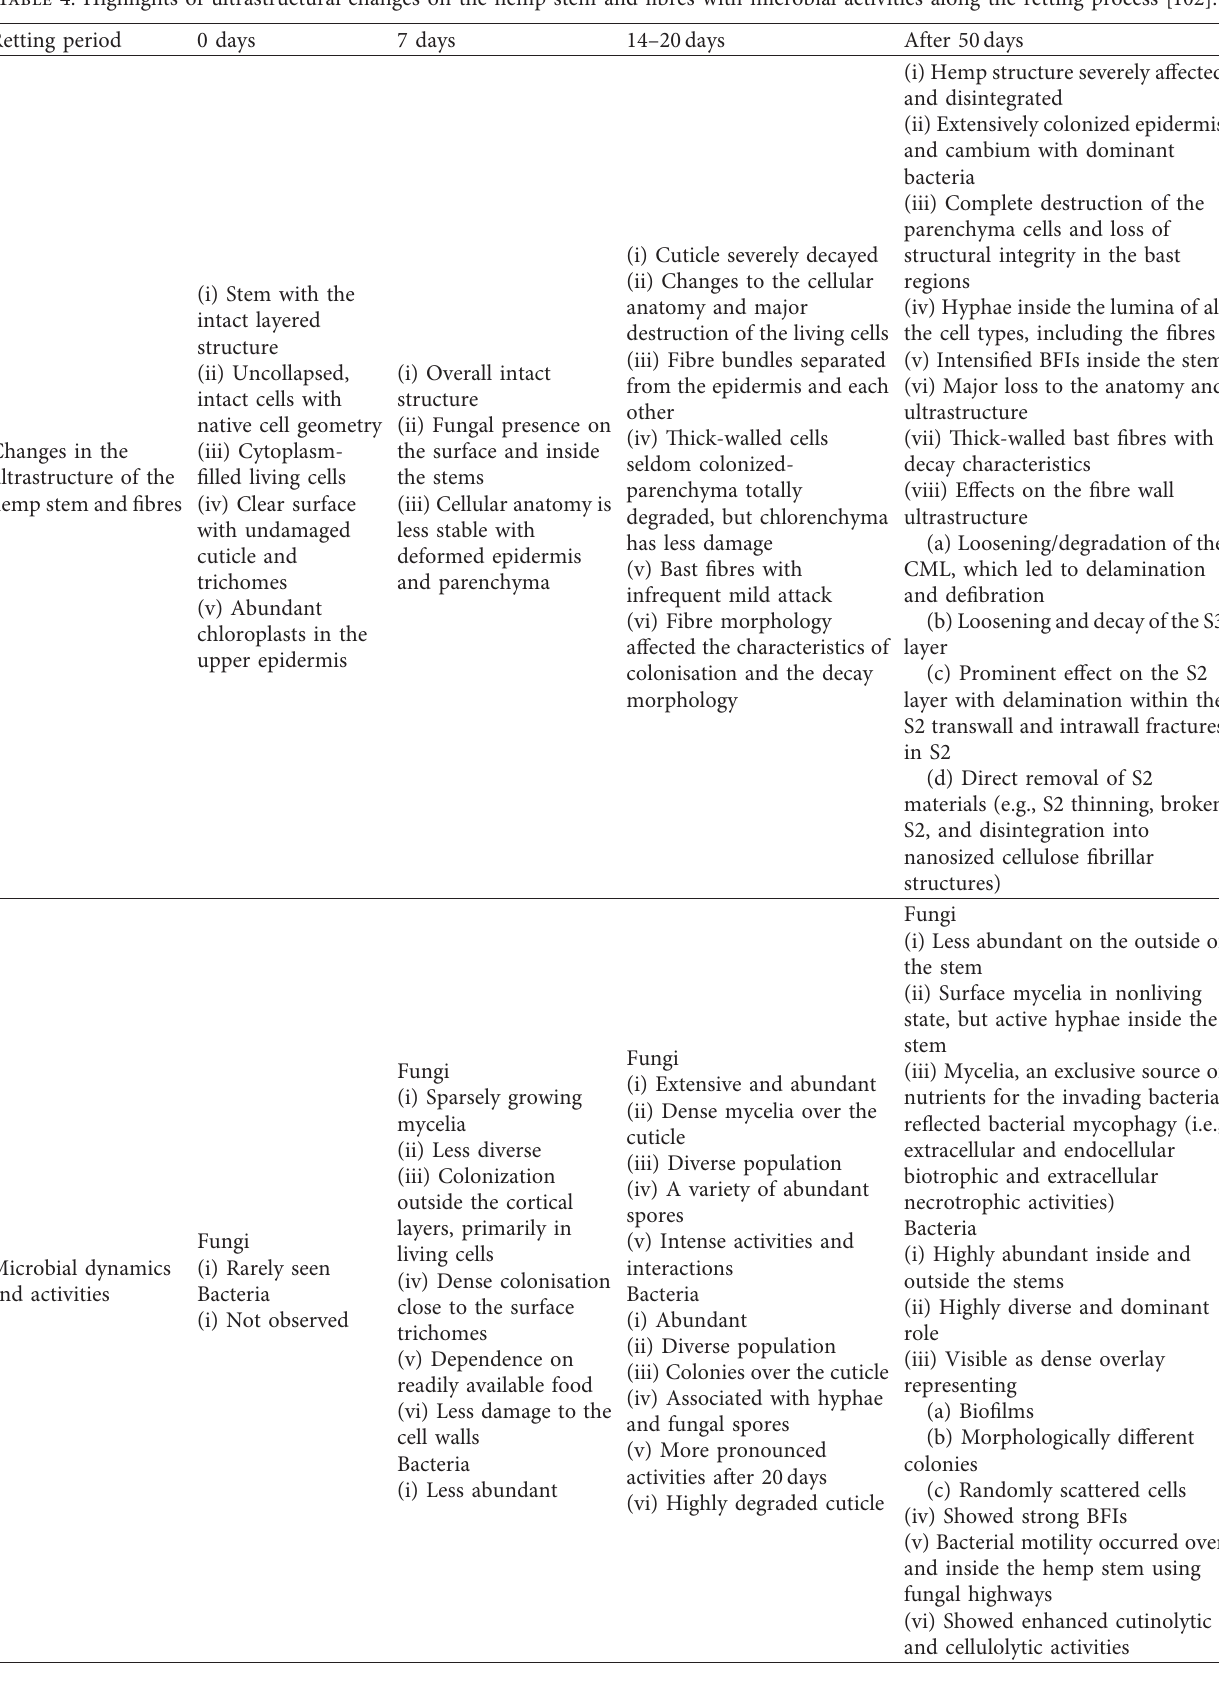
Table 4: Highlights of ultrastructural changes on the hemp stem and fibres with microbial activities along the retting process [102]. Retting